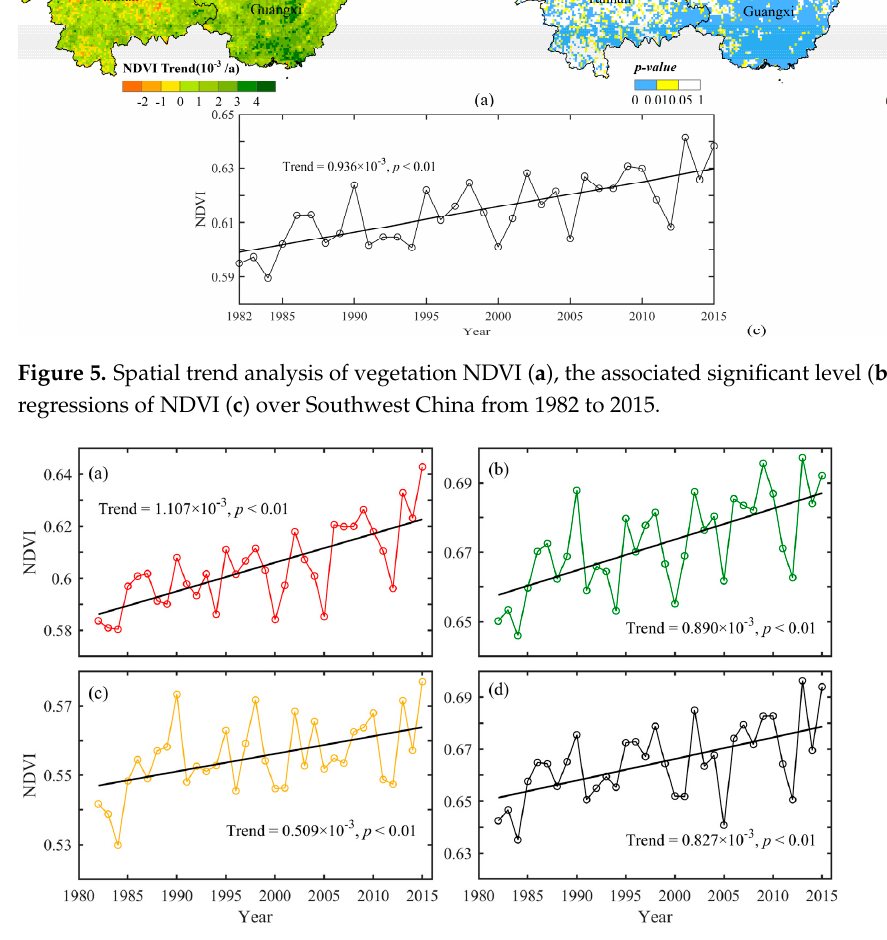
shrubland ( d ) over Southwest China from 1982 to 2015.